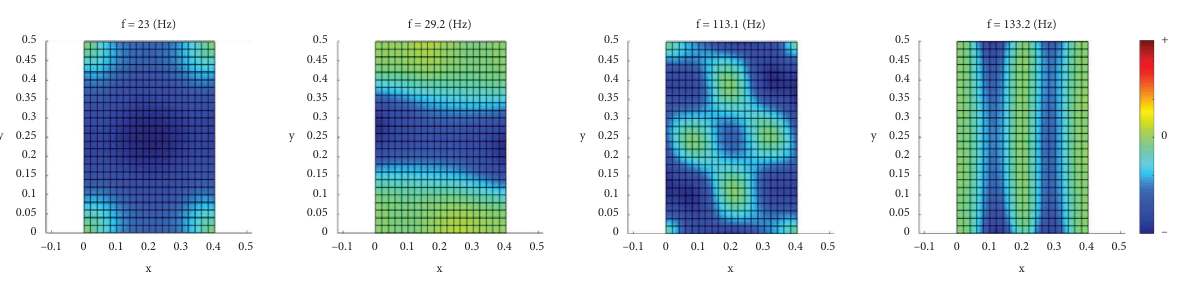
Figure 8: Stifness sensitivity analysis at four chosen frequencies.